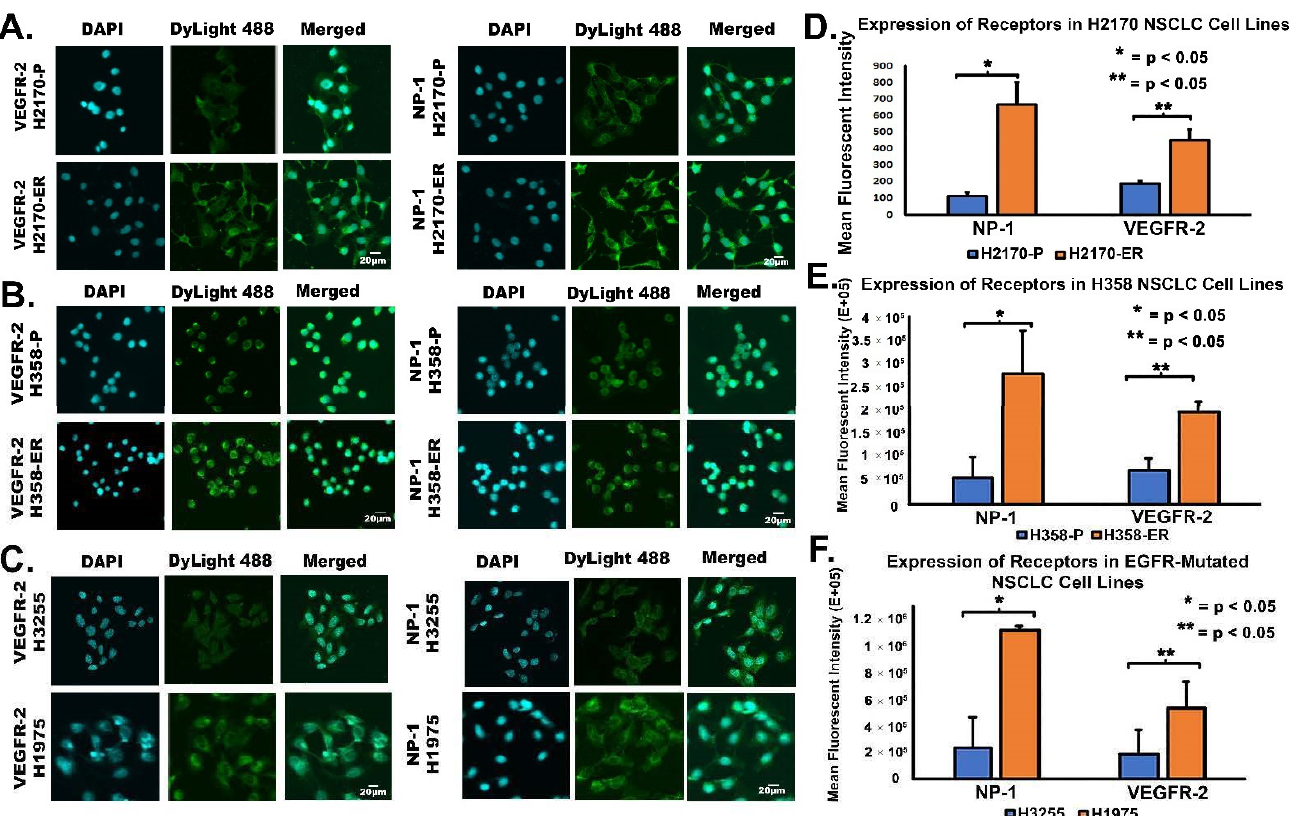
Figure 4. Immunostaining and expression of VEGFR-2 and NP-1 in NSCLC cell lines. Immunofluorescent images showing modulation in EGFR-TKI resistance-related proteins in ( A ) H2170-P/ER, ( B ) H358-P/ER, and ( C ) H1975 and H3255 cells. For the analysis, 2 × 10 4 cells per well were plated in an 8-well chamber slide, fixed, permeabilized, and probed with anti-VEGFR-2 and anti-NP-1 primary antibodies and a DyLight 488 conjugated secondary antibody for immunostaining. Nuclei were stained using DAPI, and cells were visualized using an Olympus Fluoview confocal microscope. The mean fluorescent intensities of VEGFR-2 and NP-1 receptors were graphically represented for ( D ) H2170-ER cells as compared to parental cells, ( E ) H358-ER cells as compared to H358-P cells, and ( F ) H1975 double-mutants (T790M and L858R) as compared to H3255 single-mutant (L858R) cells. Fluorescence quantifications were performed using Olympus Fluoview image analysis software, and mean fluorescent intensities are graphically depicted. Statistical analyses demonstrated that the results were statistically significant ( p < 0.05) by way of two-tailed t -test analyses. One asterisk (*) denotes the statistical significance of data concerning NP-1, whereas two asterisks (**) denote the statistical significance of data concerning VEGFR-2.